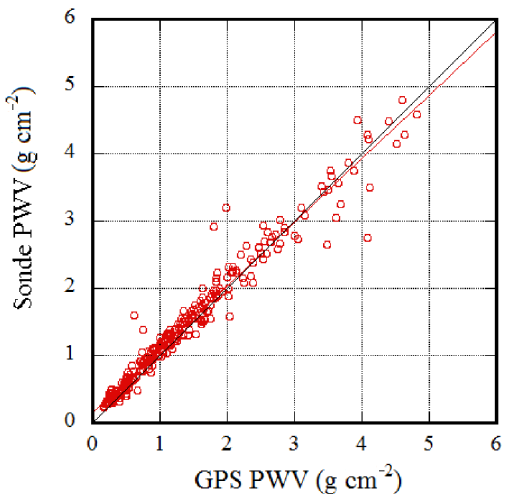
Figure 9. Scatter plot of radiosonde and POM-02 precipitable water vapor. Daytime (nighttime) measurements are indicated by a red (blue) symbol.